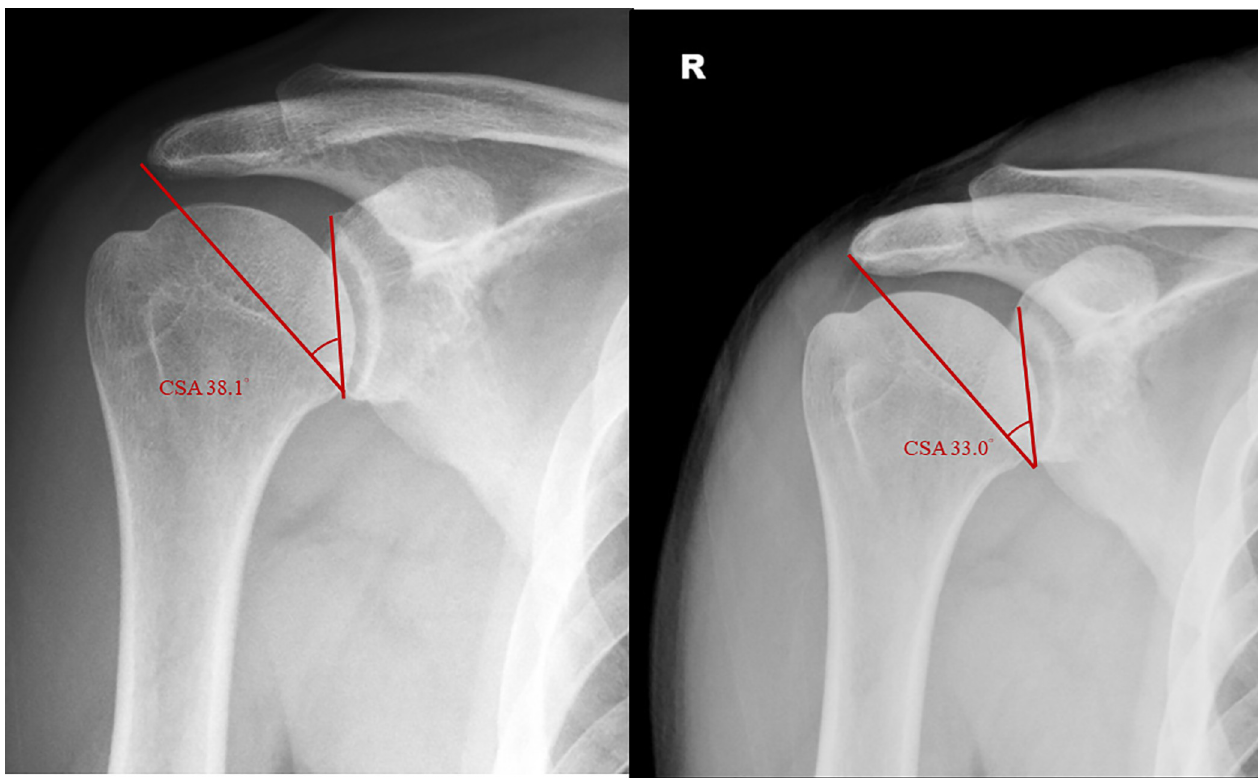
Fig 3. Demonstration of critical shoulder angle image changes before and after anterolateral acromioplasty.